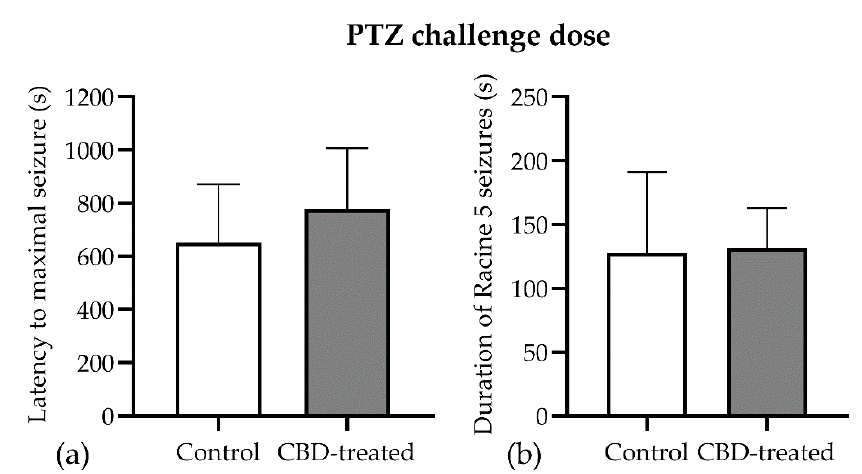
Figure 4. Lack of long-term effect of CBD (60 mg/kg) in the PTZ-kindling model. ( a ) Latency to max- imal seizure observed after PTZ injection. ( b ) Duration of the generalized seizures (clonic convulsion with loss of righting reflex and/or bouncing, two or more clonic convulsions, tonic convulsion or status epilepticus) induced by a challenge dose of PTZ. Data are expressed as mean ± SEM ( n = 7–11) for each parameter. Table 1. Cannabidiol concentrations in plasma and brain at Cmax and Cmin after the oral adminis- tration of 60 mg/kg body